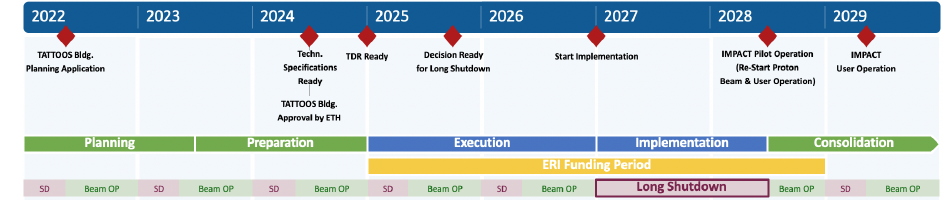
Figure 12. Timeline of the HIMB project including the main milestones. The current design of the beamlines meets the primary goal of exceeding 10 10 µ + / s de- livered rates, and we aim to prepare a final beamline layout with corresponding particle rates and envelopes by the end of